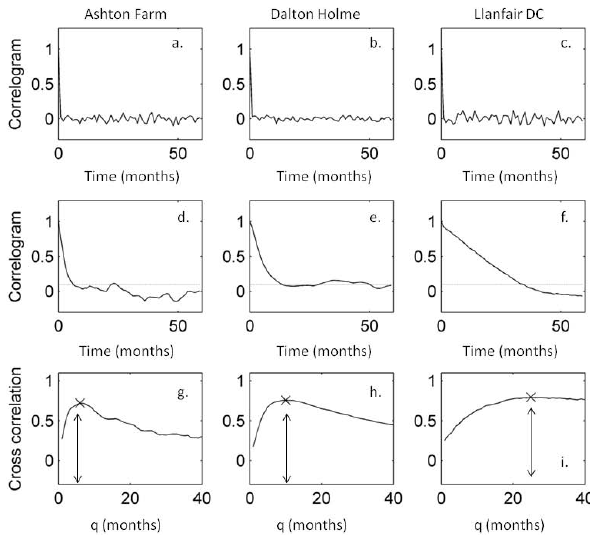
Fig. 7. (a) – (c) SPI correlograms for Ashton Farm (left panels), Dal- ton Holme (centre panels) and Llanfair (right panels), (d) – (f) SGI correlograms for the corresponding sites, where the dashed line is the SGI autocorrelation threshold, t SGI , and (g) – (i) plots of cross- correlation between SGI and SPI as a function of SPI accumulation period in months for the corresponding sites. The maximum corre- lation between SGI and SPI is denoted by a cross on the curve and an associated value of q can be identified, denoted by the vertical arrows below the